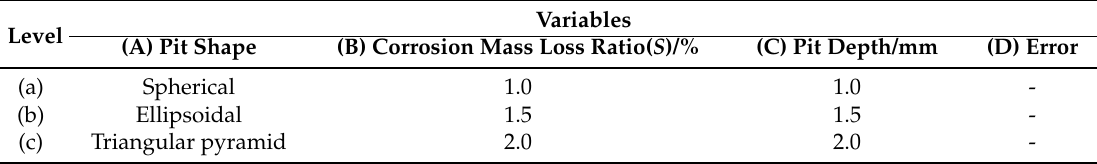
Table 5. Variables and levels for orthogonal test.